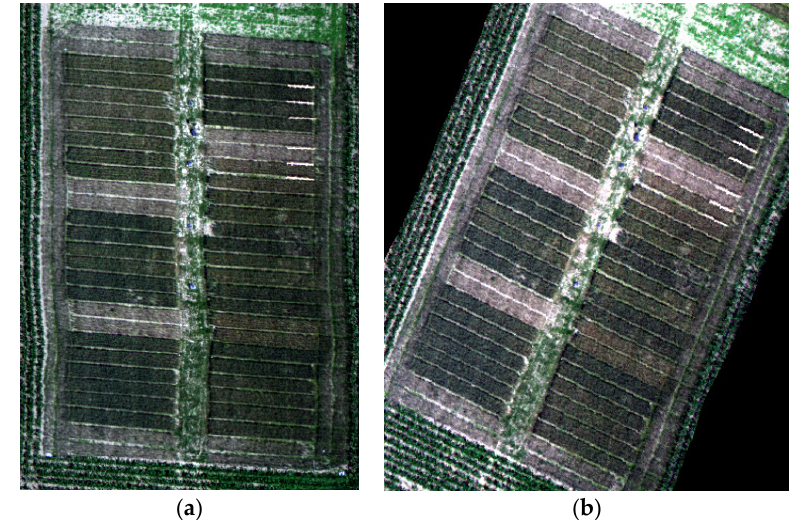
Figure 4. Raw geometry of imagery ( a ) and orthorectified imagery ( b ).